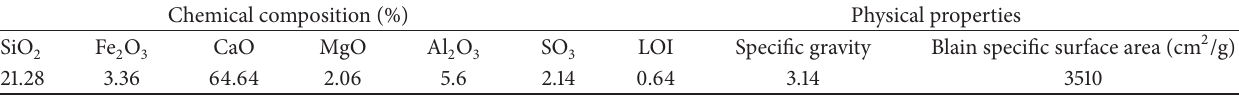
Table 1: Chemical composition and physical properties of